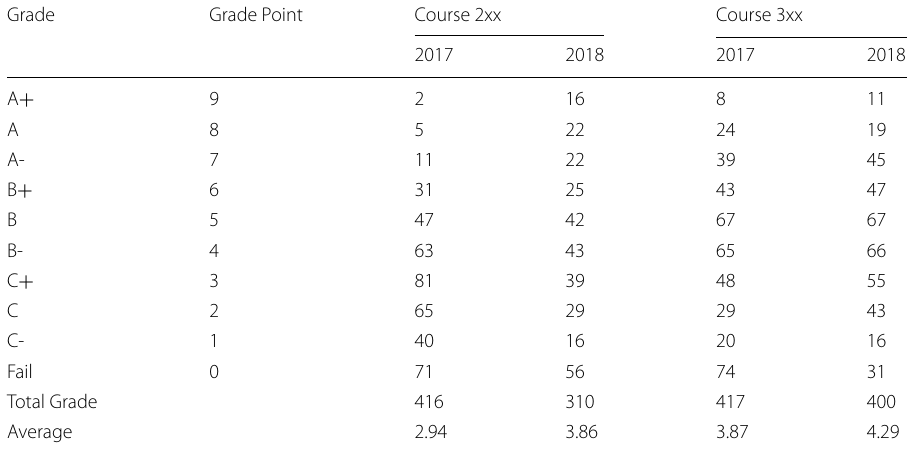
Table 6 Raw grade distributions in the two courses – 2017 had no repeat assessments while 2018